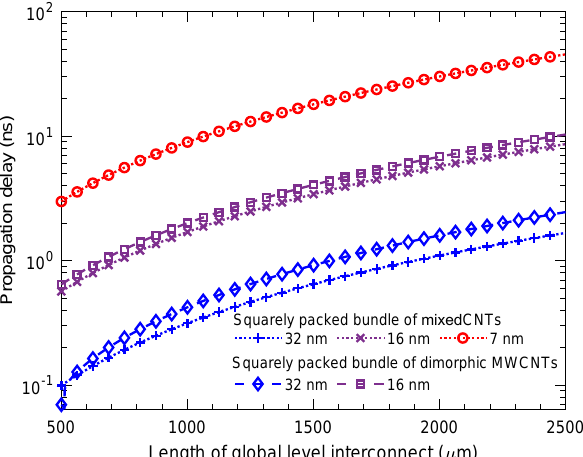
Figure 9. Demonstration of comparison between the propagation delay performance of a squarely packed bundle of mixed CNTs and that of dimorphic MWCNTs for global-level interconnect lengths. The size and number of accommodated CNTs for different technology nodes are mentioned in Table